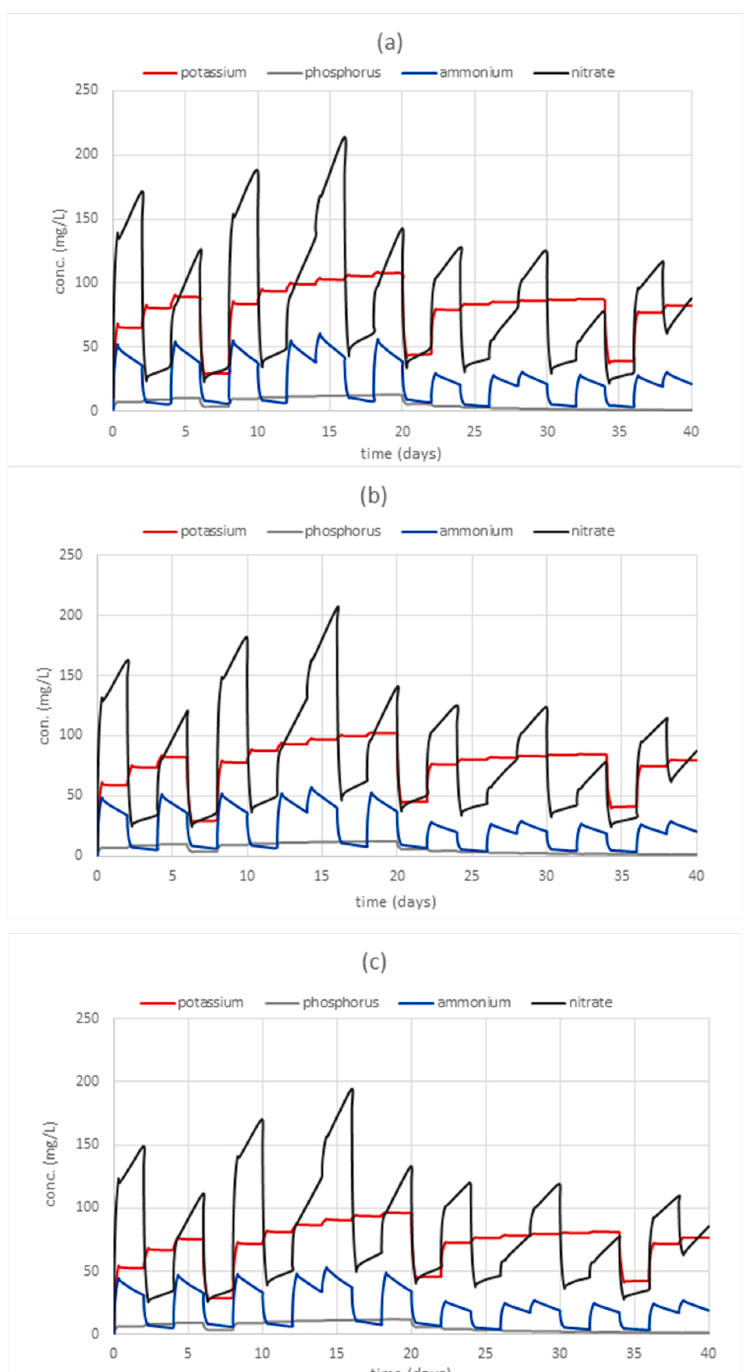
Figure 2. Temporal variation in fertilizer concentration at observation points on the emitter for strategy C using a DI system and different soil types, ( a ) sand, ( b ) loamy sand, and ( c ) sandy loam.